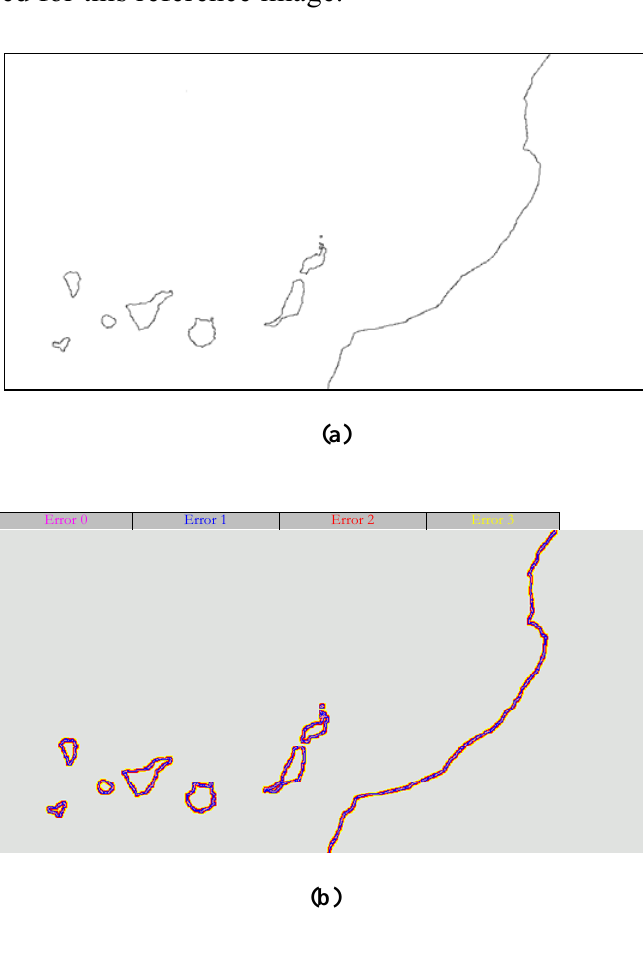
Figure 5. Registration Accuracy Estimation Technique: (a) Example of a reference image (coastlines) extracted from a geographic database (27-33º N, 8-19º W and, (b) error field generated for this reference